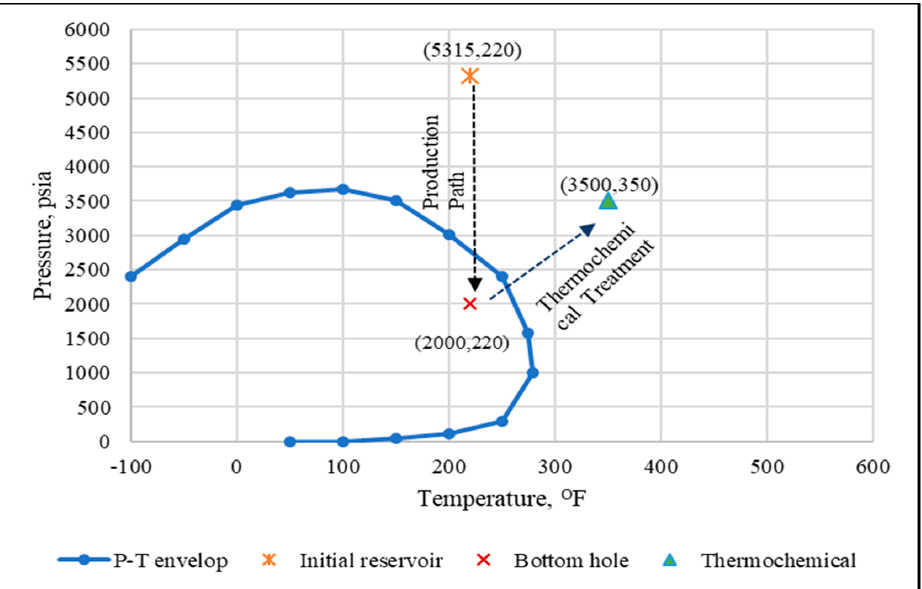
Figure 4. Alterations of condensate behavior due to thermochemical treatment, at reservoir